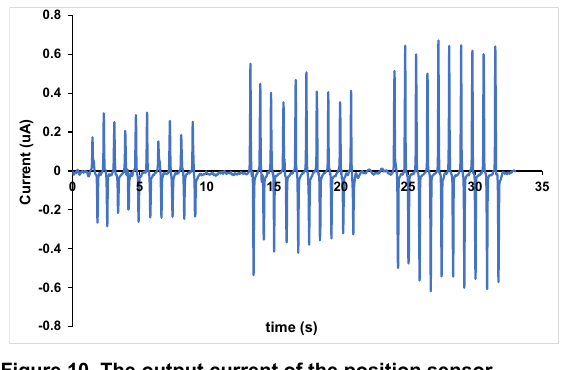
Figure 9. Schema of the characterization method for the location detecting sensor based on a 16-turns spiral TENG. As seen in Fig. 10, by changing the object's position toward the center of the device, the peak to peak output current is averagely increased from 0.5 to 1 and then to 1.4 µA. The sensor's sensitivity is calculated and plotted vs. relative position in Fig. 11. It is seen that the sensitivity of the sensor is linearly increased when the object gets closer to the center of the circle. The considered positions can be increased by decreasing the width of the force applicator, which is connected to the PU layer.